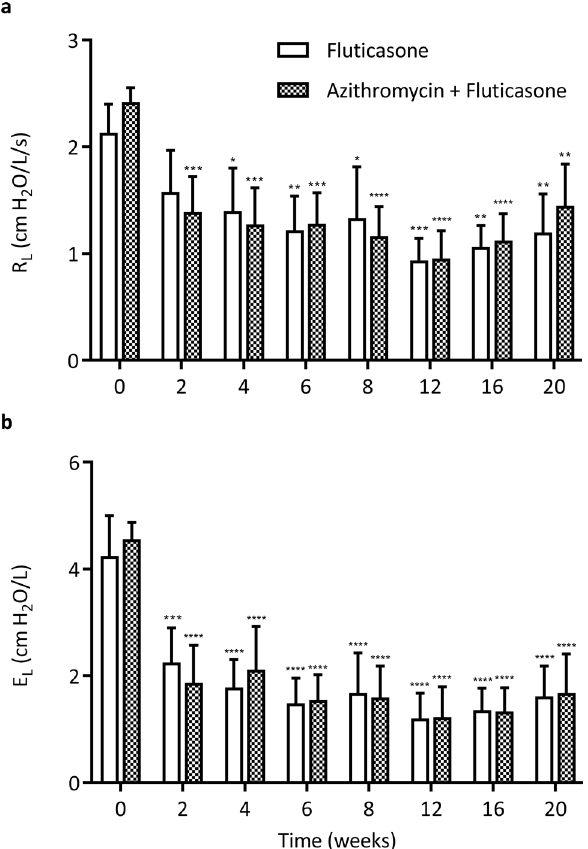
Figure 1. Lung function measured by standard respiratory mechanics. Values of pulmonary resistance (R L ; a ) and pulmonary elastance (E L ; b ) (mean and standard error of the mean). There was a significant main time effect but not group difference with the two-way ANOVA (p < 0.0001) for both R L and E L . *p < 0.05, **p < 0.01, ***p < 0.001, ****p < 0.0001 compared to baseline values with Dunnett’s multiple comparison tests.